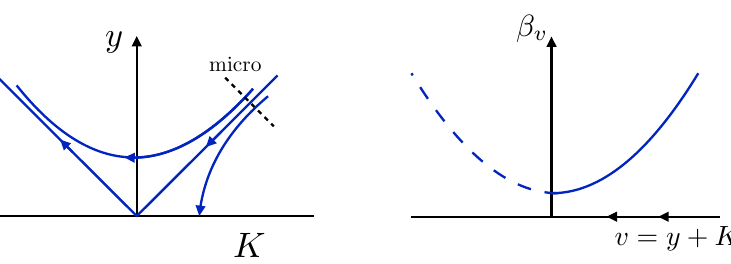
Figure 8 . Left: the RG (cid:13)ow diagram for the BKT transition. Right: the beta-function for the coupling combination v